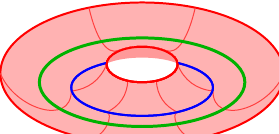
Figure 9. The configuration obtained by making two annular branes intersect at a finite radius r = r ∗ (shown in blue). We also show the conical defect (in green). Both the corner and the conical are τ